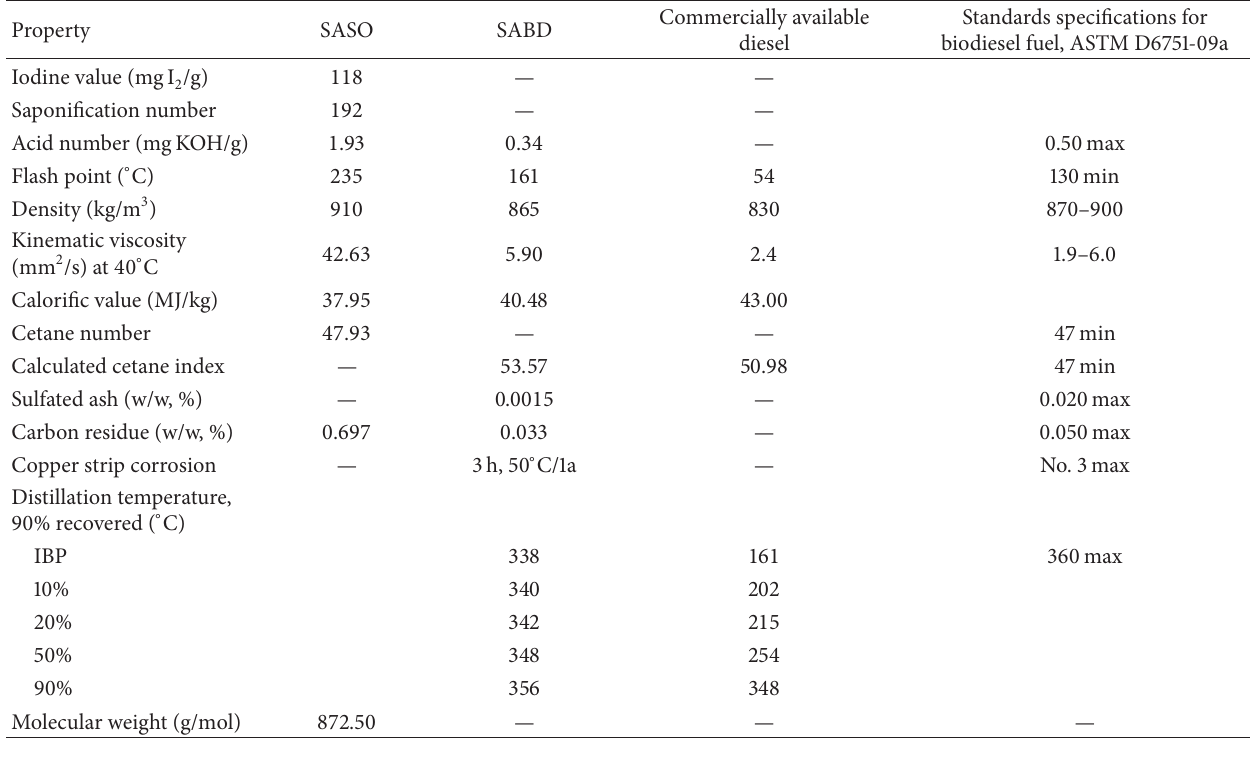
Table 3: Physiochemical properties of SASO and SBD in comparison with commercially available diesel and ASTM standard specifications for biodiesel fuel.